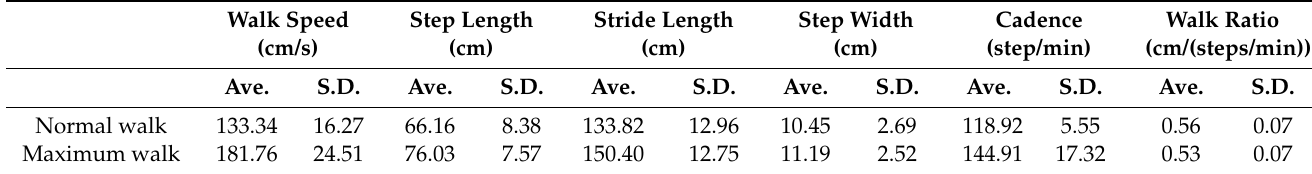
Table 7. Comparison of gait factor during the normal walking and maximum walking of ordinary individuals. Walk Speed